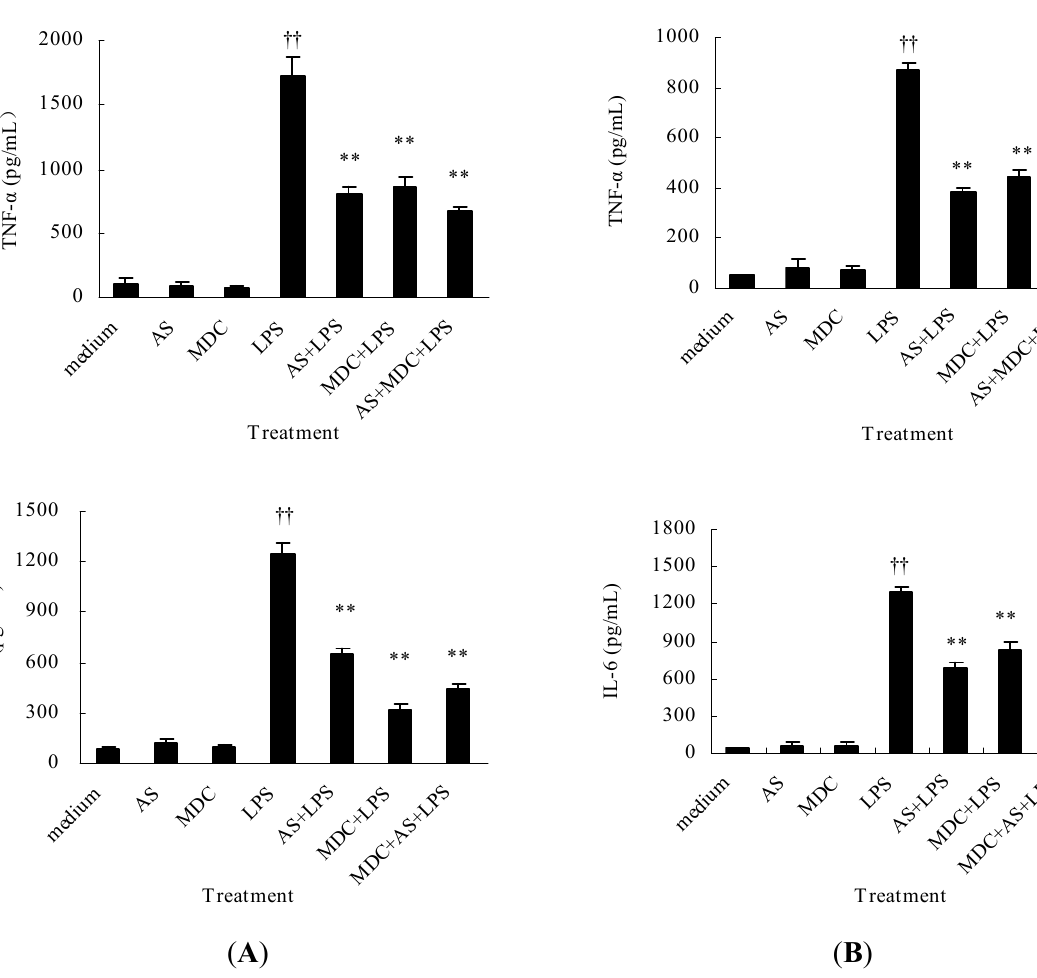
Figure 7. Inhibition of AS on TNF- α and IL-6 release induced by LPS from peritoneal macrophages ( A ) or liver Kupffer cells ( B ). Cells (1.0 × 10 6 cells/mL, 0.4 mL)